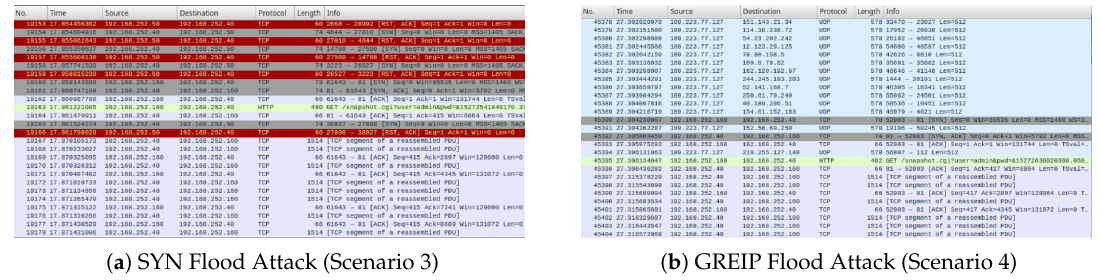
Figure 6. IoT Camera Video Feed (scenario three and four).